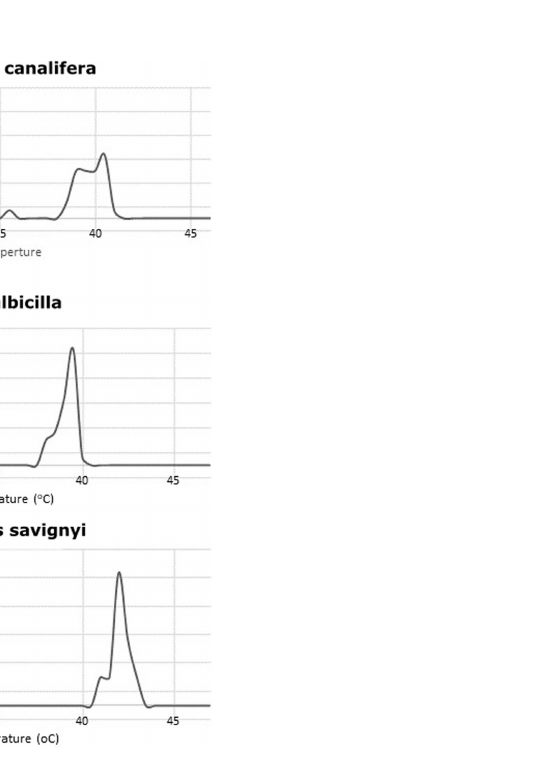
three species of gastropods; it shows an inverse relationship between LT 50 and body size (Figure 3). Linearity between lethal temperatures and median critical thermal maxima was calculated as R 2 = 0.47, which de fi nes a variation in CT max to validate the ef fi cacy of short-term estimates so as to predict long-term